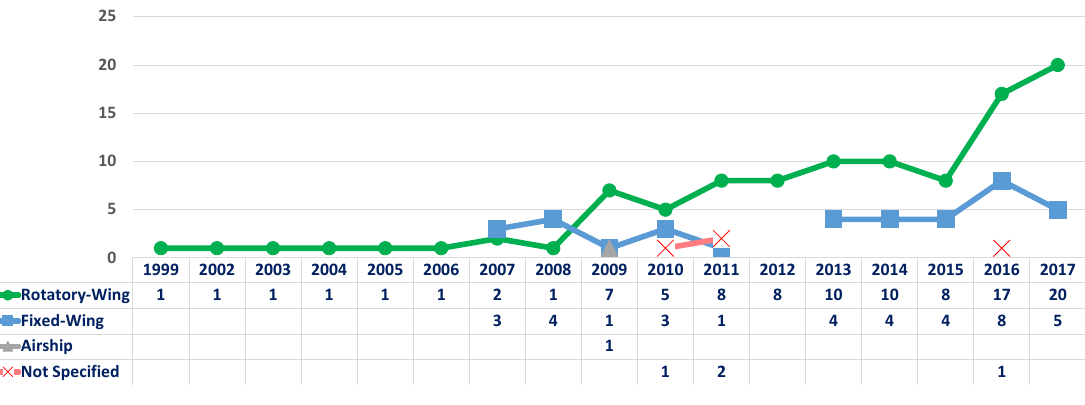
Figure 12. Annual trend per UAV